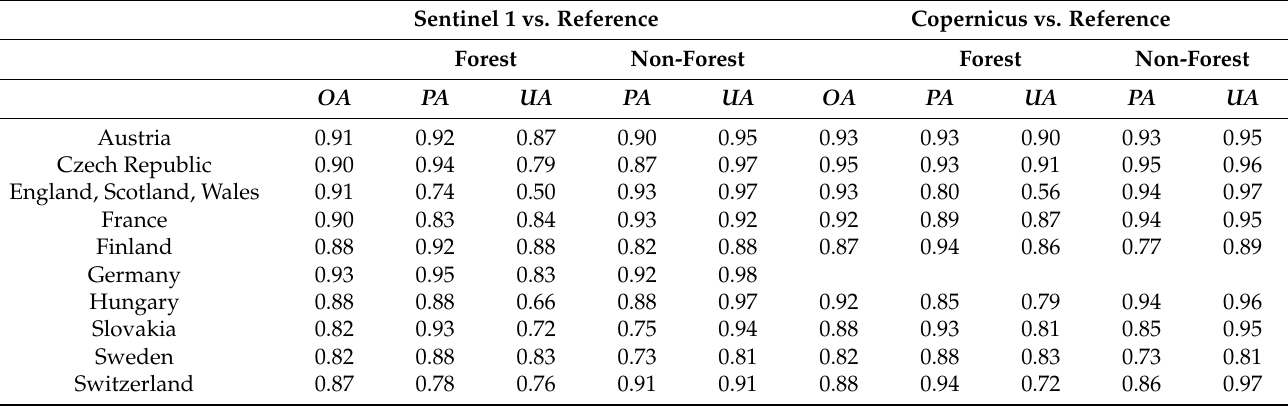
Table 3. Results of the accuracy assessment using the national datasets for the forest/non-forest classification. The following statistics are listed: overall accuracy ( OA ), producers’ accuracy ( PA ) and users’ accuracy ( UA ).